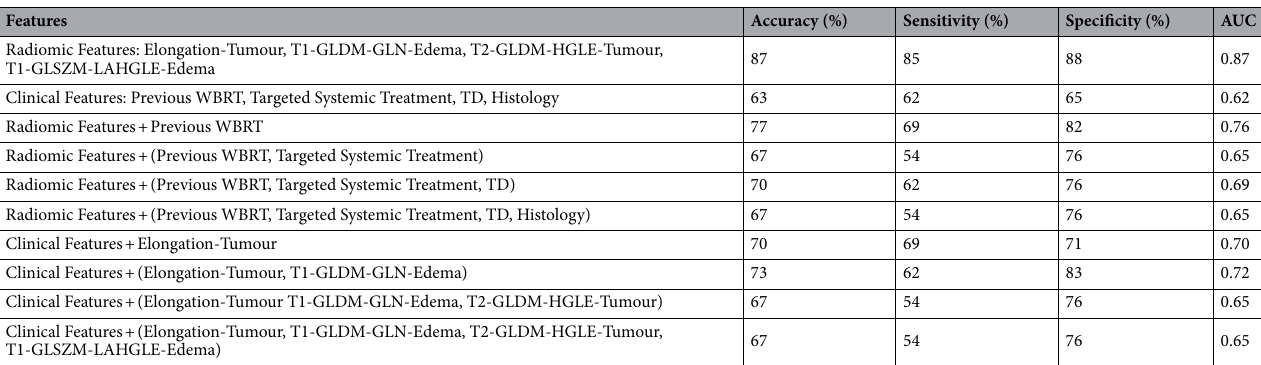
Table 2. Results of a priori outcome prediction on the independent test